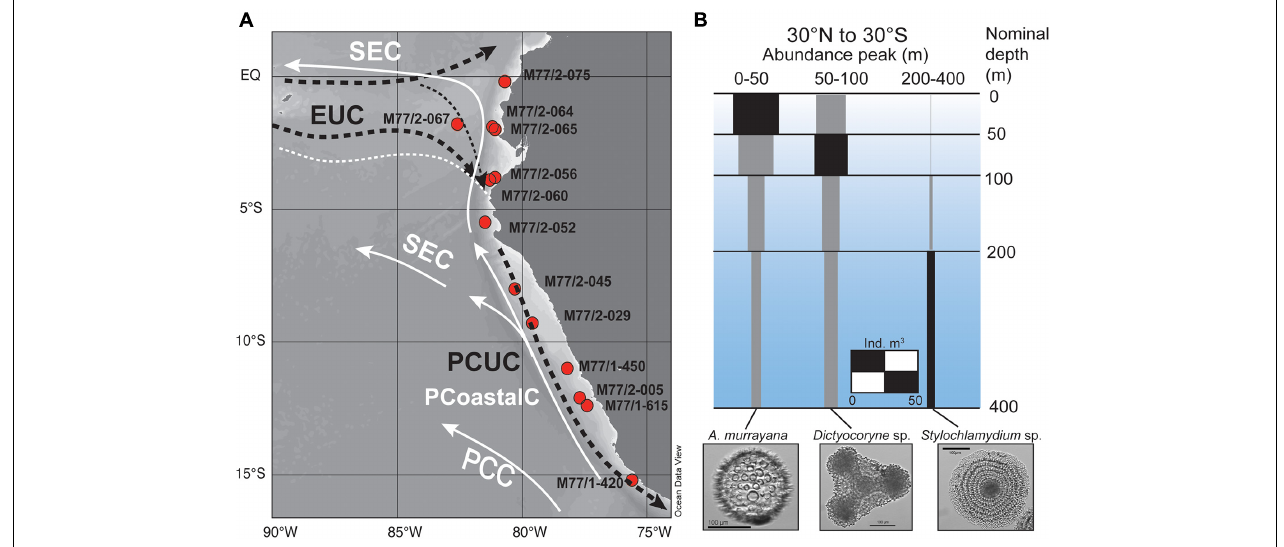
FIGURE 1 | (A) Map of surface sediment sampling stations for radiolaria taken during cruises M77/1 and M77/2. Surface currents (white solid lines) are indicated for the equatorward flowing Peru Coastal Current (PCoastalC) and the South Equatorial Current (SEC), the main subsurface currents (indicated by dashed black lines) are the Equatorial Undercurrent (EUC) and the Peru-Chile Undercurrent (PCUC) flowing in 50–150 m water depth. (B) Global water column abundance peaks of Acrosphaera murrayana , Dictyocoryne profunda/truncatum , and Stylochlamydium venustum between 30 ◦ N and 30 ◦ S (individuals per m 3 ; modified from Boltovskoy et al.,